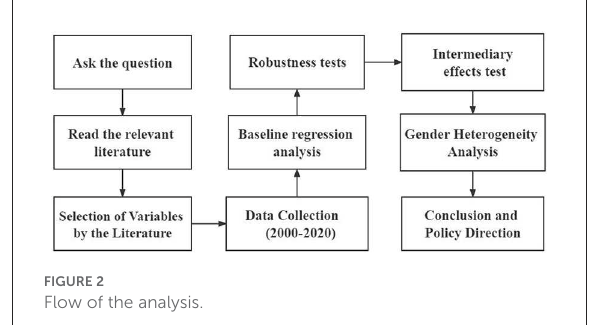
FIGURE2 Flow of the